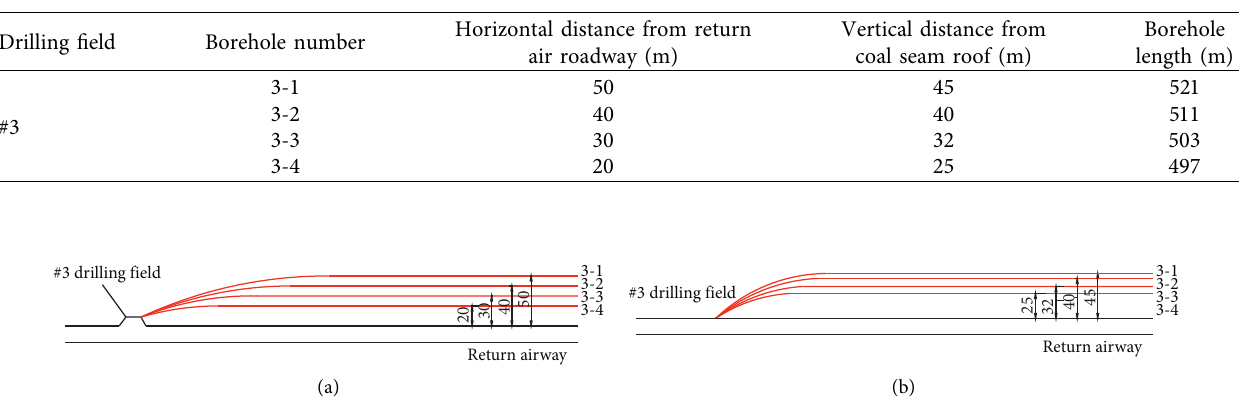
Figure 12: High directional drilling layout of #3 drilling site (m). (a) Floor plan. (b) Section plane.